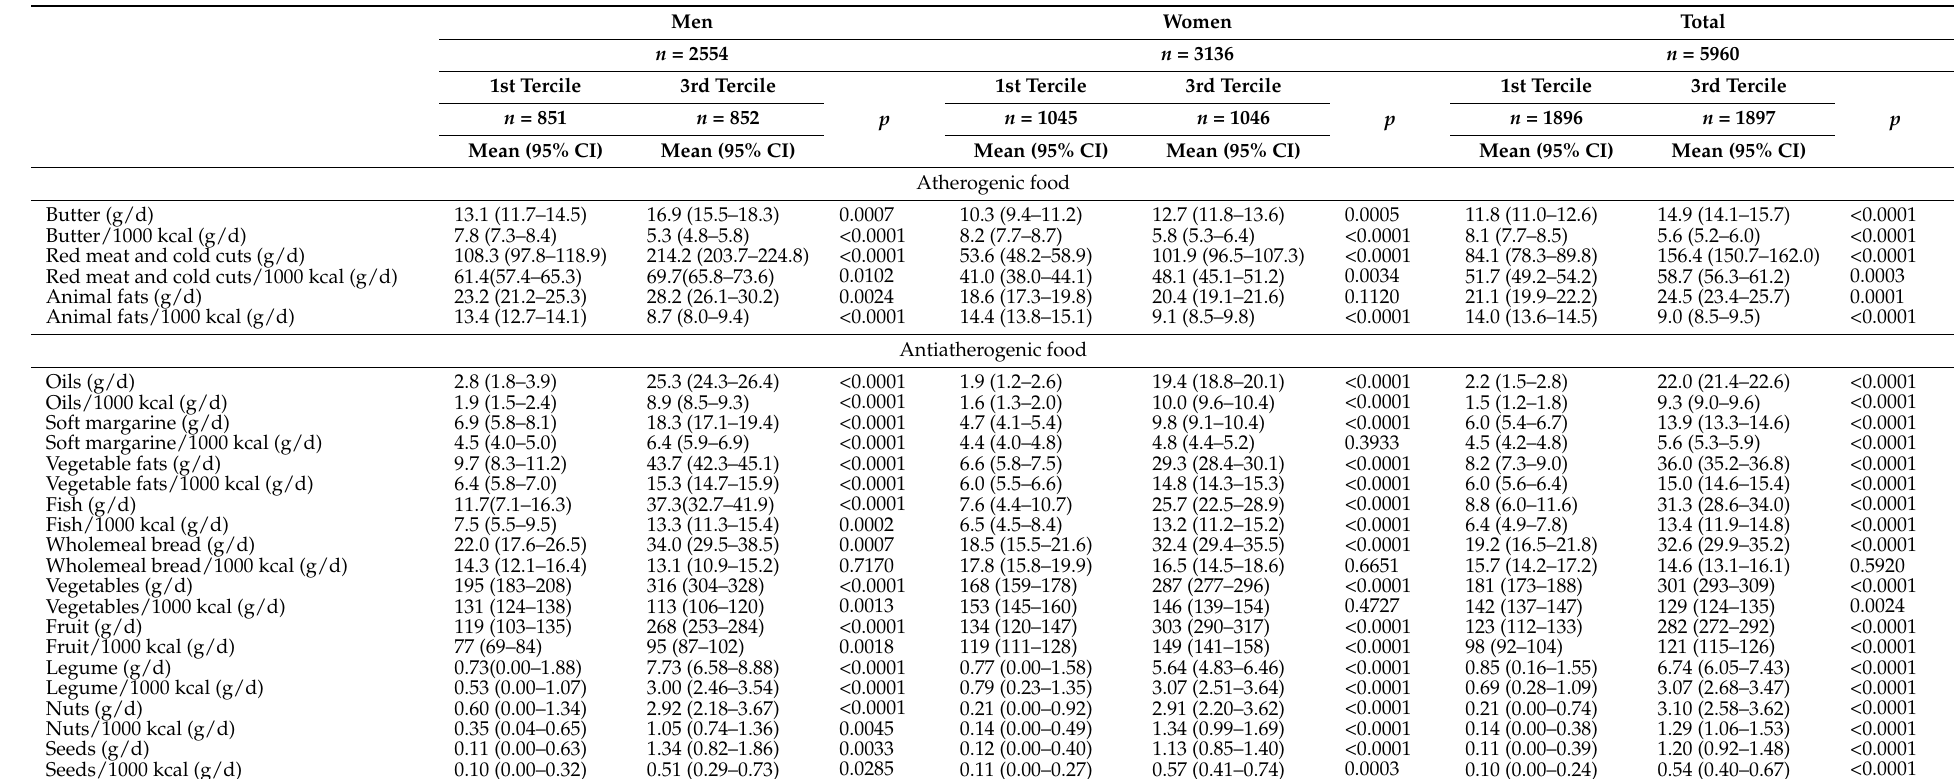
Table 5. Consumption of selected products by tercile of phytosterol intake (1st tercile vs. 3rd